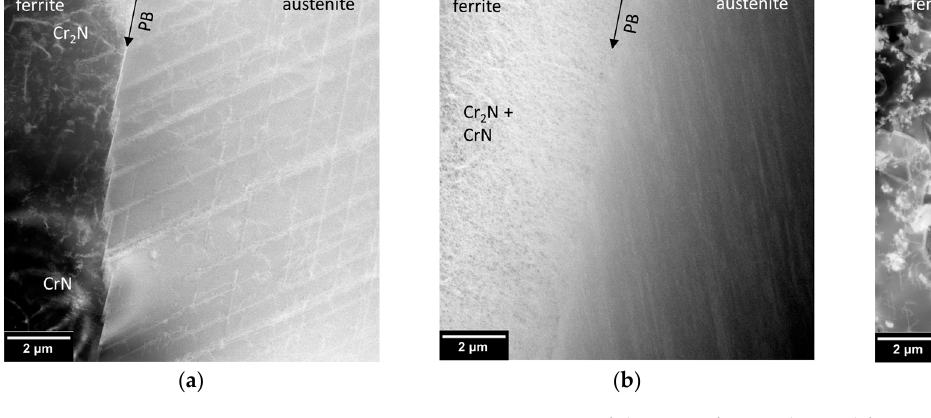
Figure 4. ADF-STEM images of the DSS after isothermal fatigue at ( a ) 20, ( b ) 300 and ( c ) 600 °C (PB marks the phase boundaries).